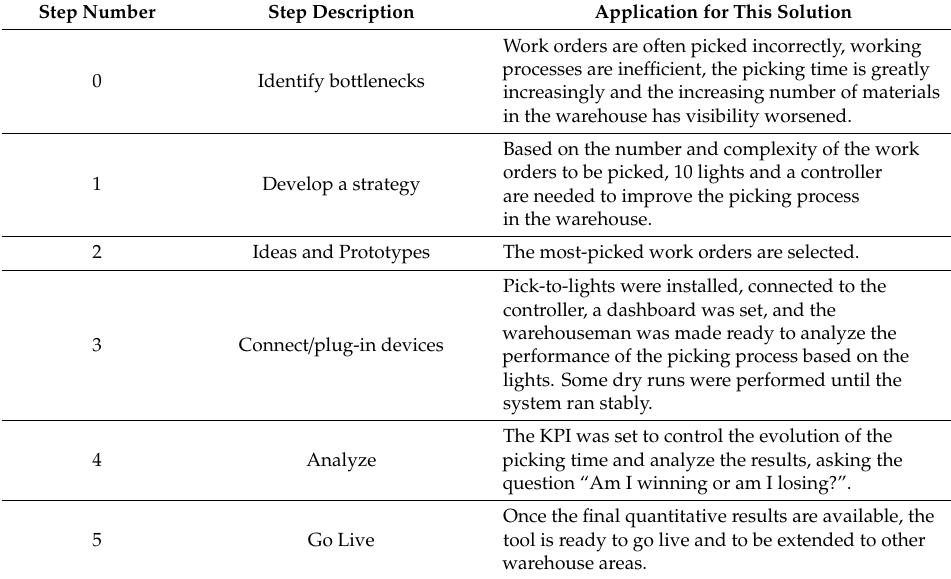
Table 6. Pick-to-light—implementation